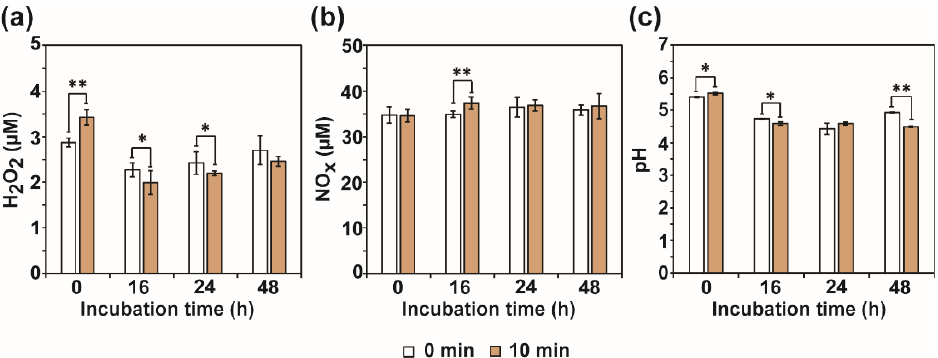
Figure 8. Levels of H 2 O 2 ( a ), Nox ( b ), and pH ( c ) in media after exposure to RF-EMF (2 GHz, 0.01 W). Each value represents the mean of nine replicate measurements. The experiment was repeated three times, each with three replicate measurements: * p < 0.05 and ** p < 0.01.